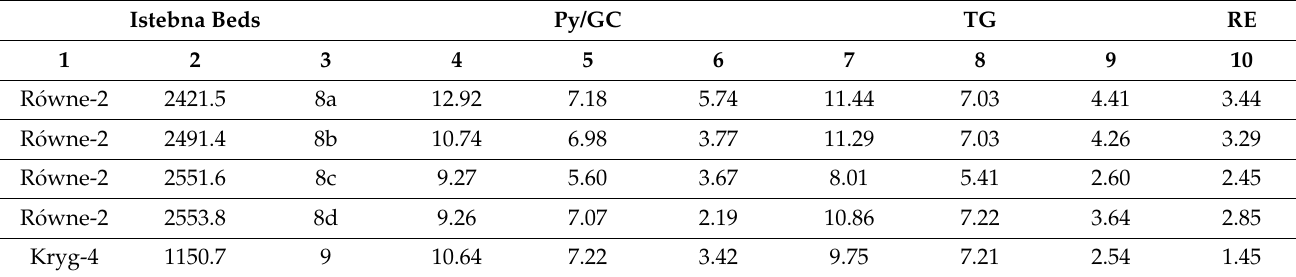
Table 4. Comparison of the weight loss of samples representing Istebna Beds in the three-stage Py/GC and TG analyses. Istebna Beds Py/GC